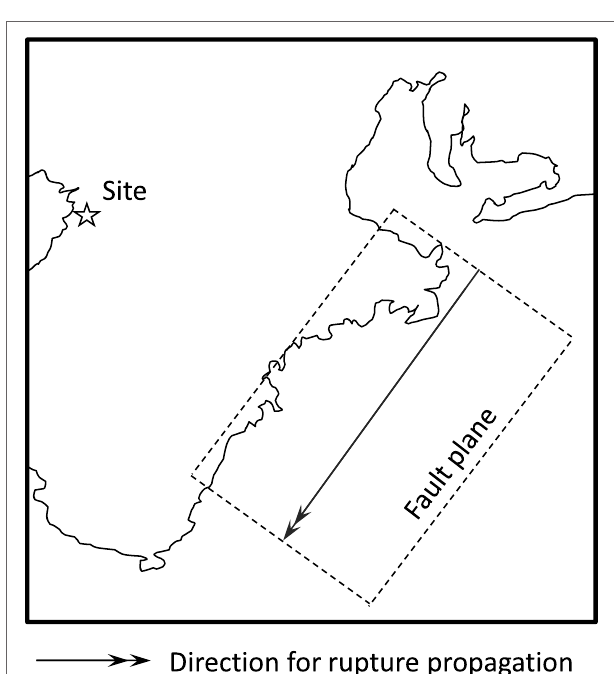
FIGURE 9 | Assumed fault plane and observed site in Osaka